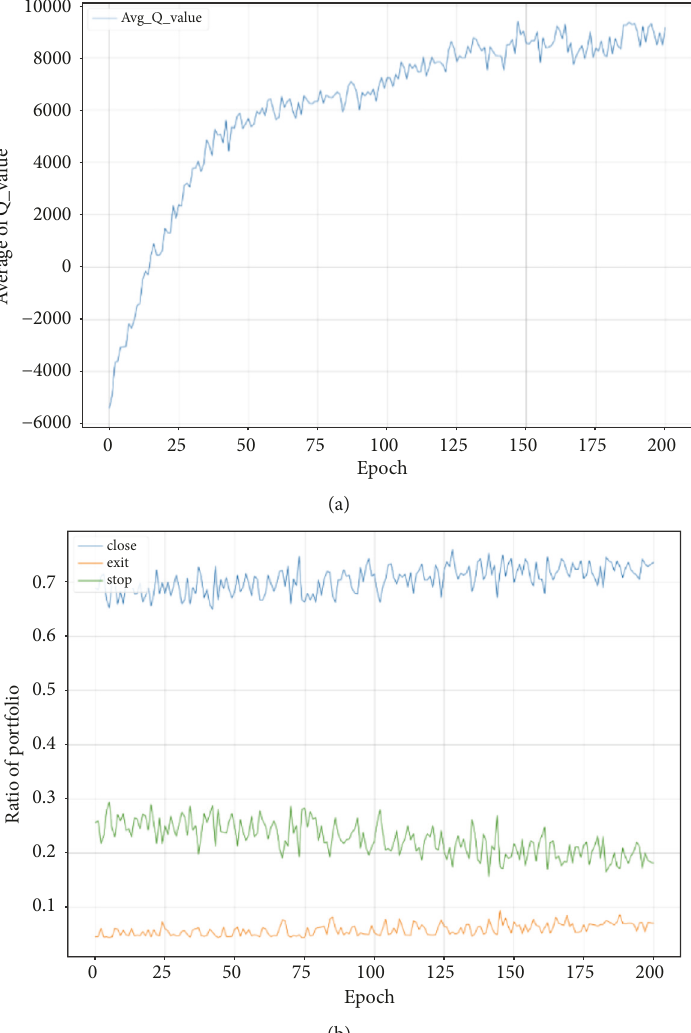
Figure4:Verificationthatourproposedmodeliswell-trainedwithHONandTXNusingTLS.(a)AverageofQ-values. (b)Ratioofportfolios.